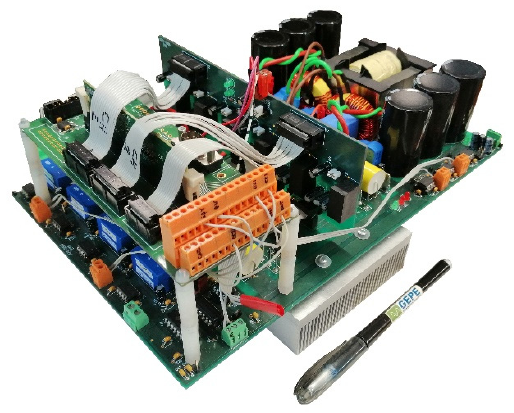
Figure 6. Photography of the prototype developed for the unified power converter.